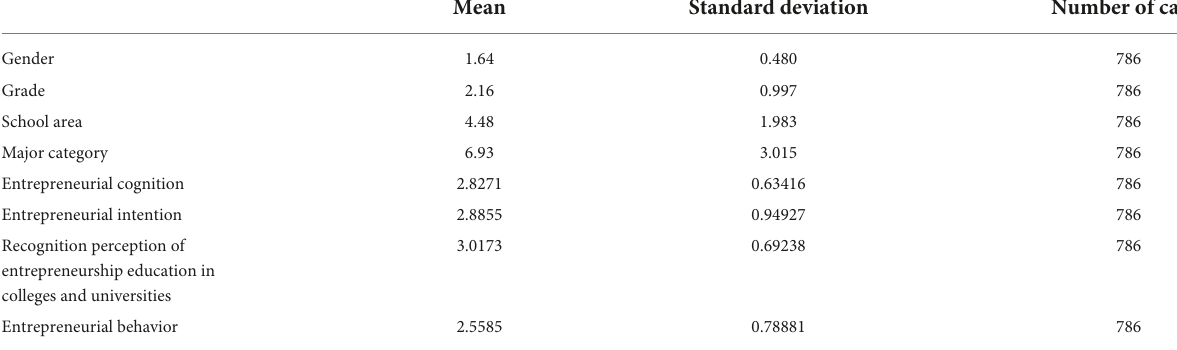
TABLE 3 Descriptive